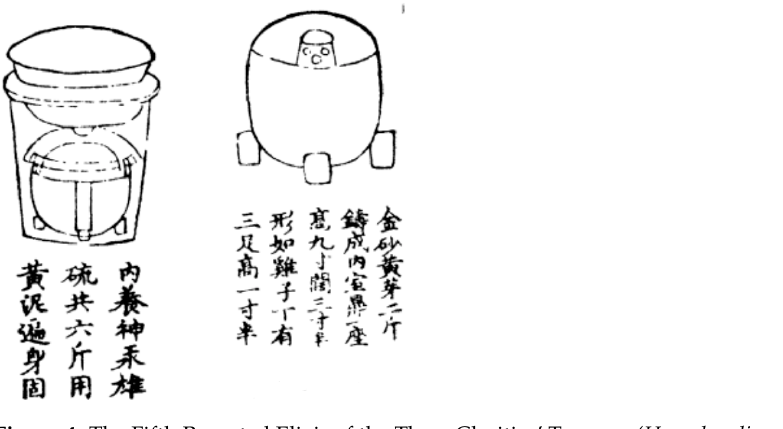
Figure 4. The Fifth Reverted Elixir of the Three Clarities’ Treasure ( Huandan diwu zhuan sanqing zhibao dan 還丹第五轉三清至寶丹 ) and the diagram of its refiner (Bai 1988b, p. 166a).